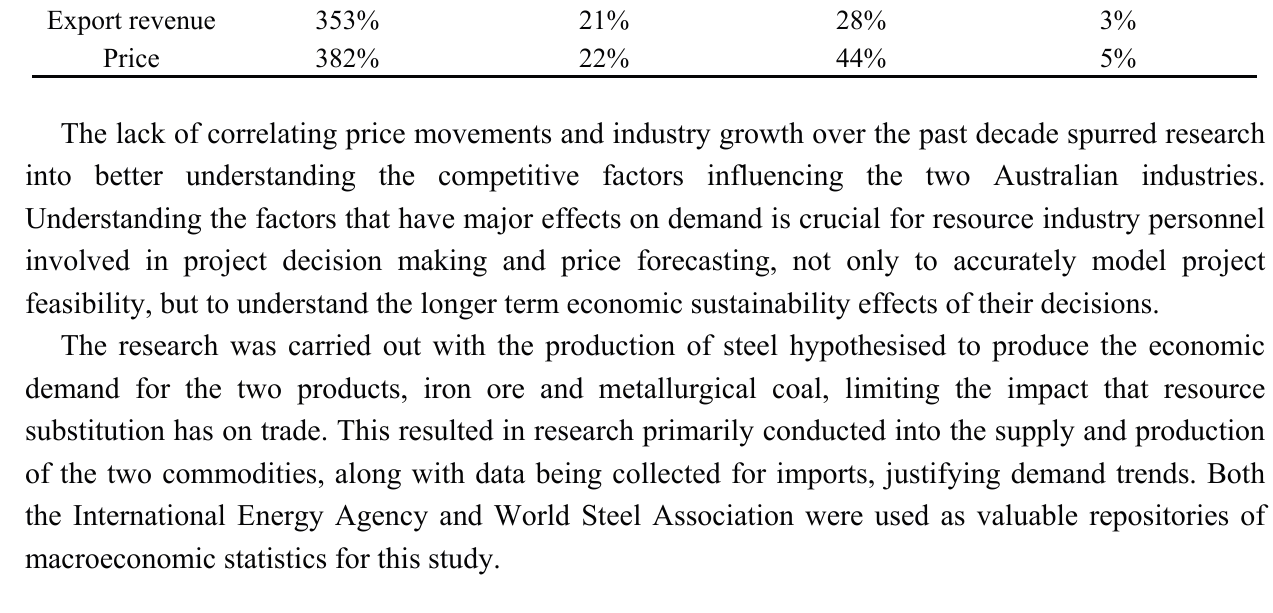
Table 1. Australian iron ore and metallurgical coal industry growth since 2005 [2,3]. Measure Iron Ore Industry Measure Export